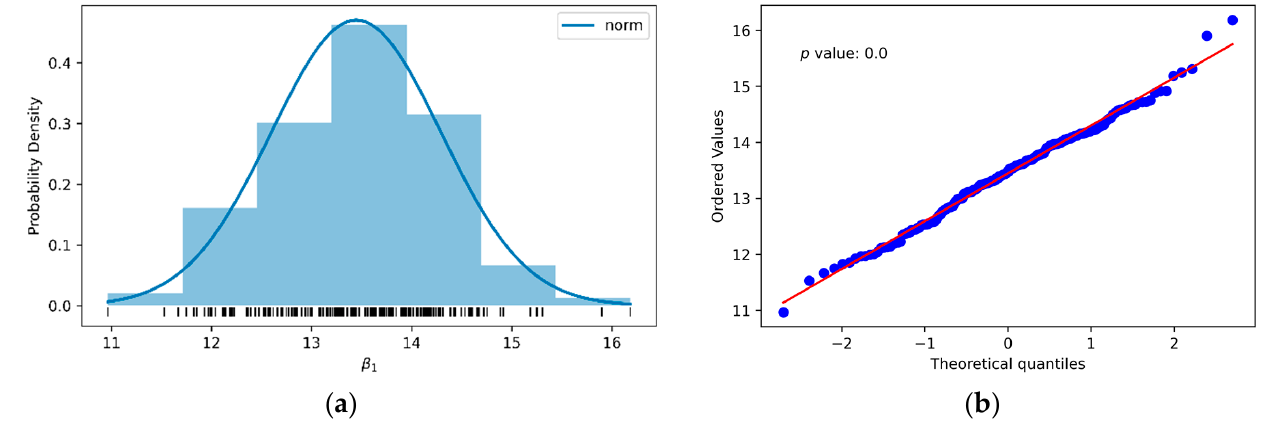
Figure 14. Histogram ( a ) and normal distribution graph ( b ) of the slope β 1 of the linear fit by ordinary least squares of 10 data pairs, of σ c (50) and I s (50) ) of the travertine, randomly selected from 200 random samples. Table 12. Results of the normal distribution of the linear fit for the σ c and I s pairs of the travertine. Parameter